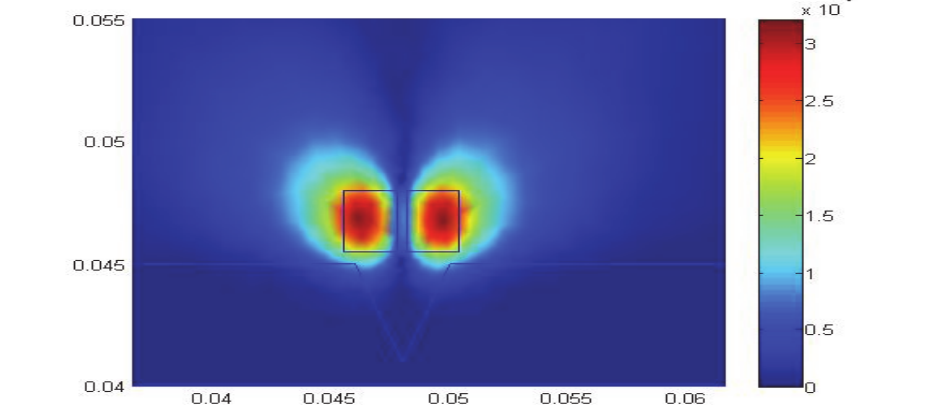
Figure 2: Representation of the potential vector.